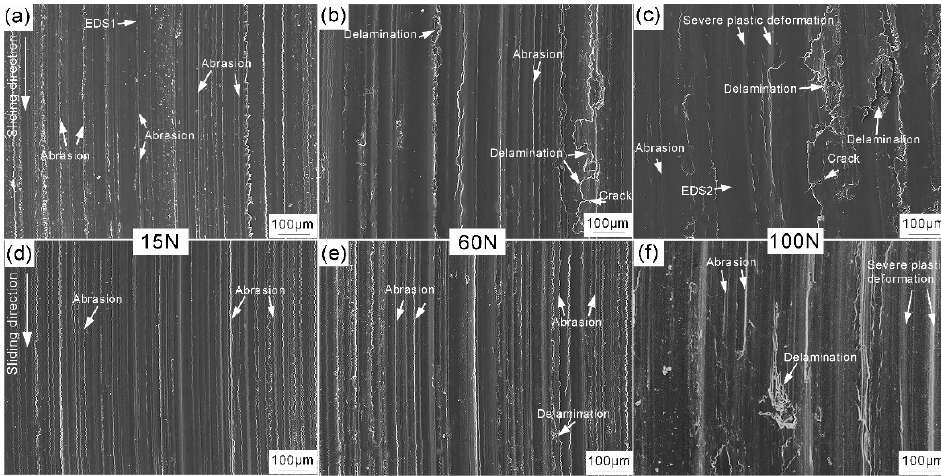
Figure 7. Worn surface morphology of surfacing magnesium alloys: ( a – c ) AZ91 alloy, ( d – f ) AZ91 + 0.5 Gd alloy. The sliding direction is from top to bottom.